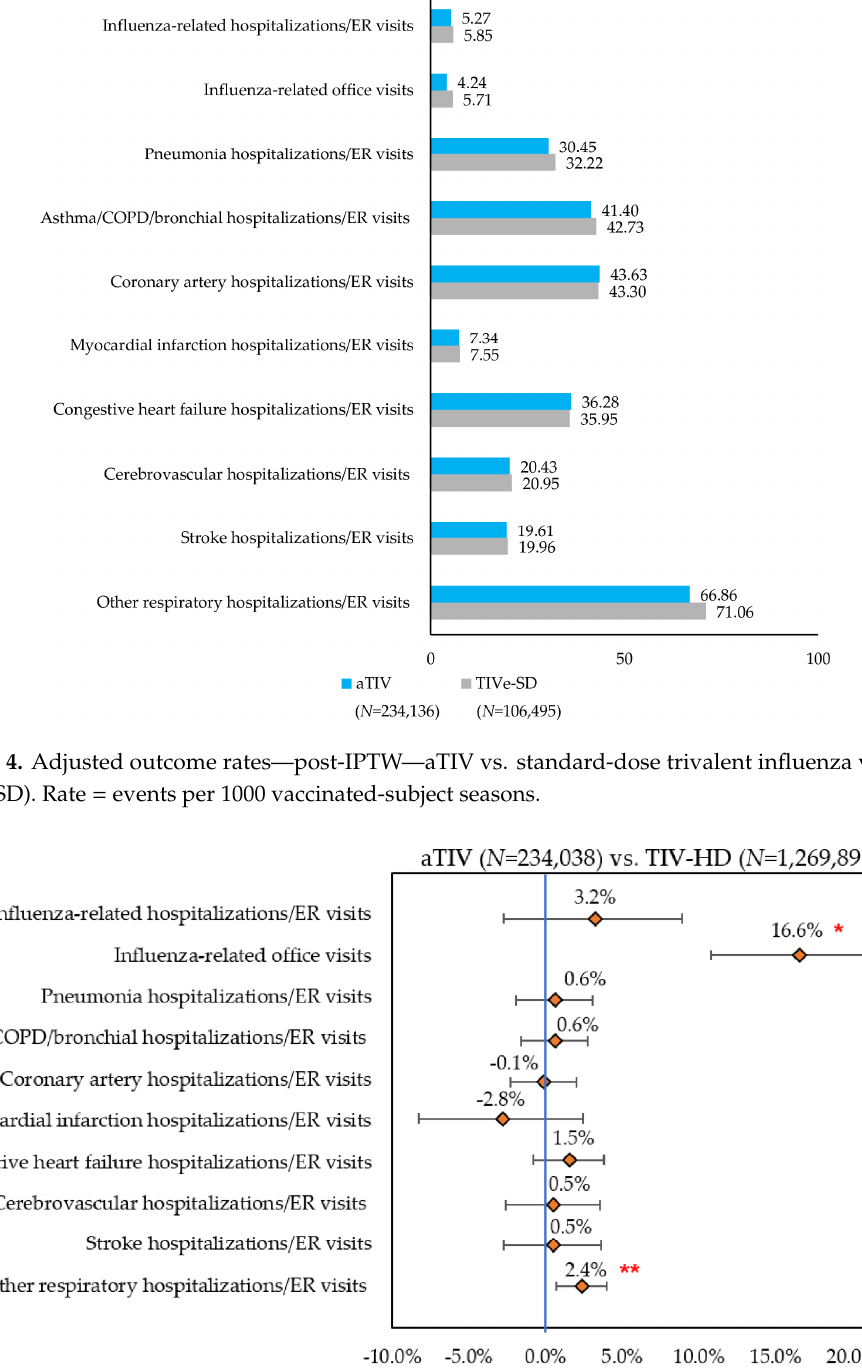
Figure 5. Adjusted relative vaccine effectiveness (rVE) — post-IPTW and Poisson regression — aTIV vs. TIV-HD. * p < 0.001; ** p < 0.01; rVE = relative vaccine effectiveness.